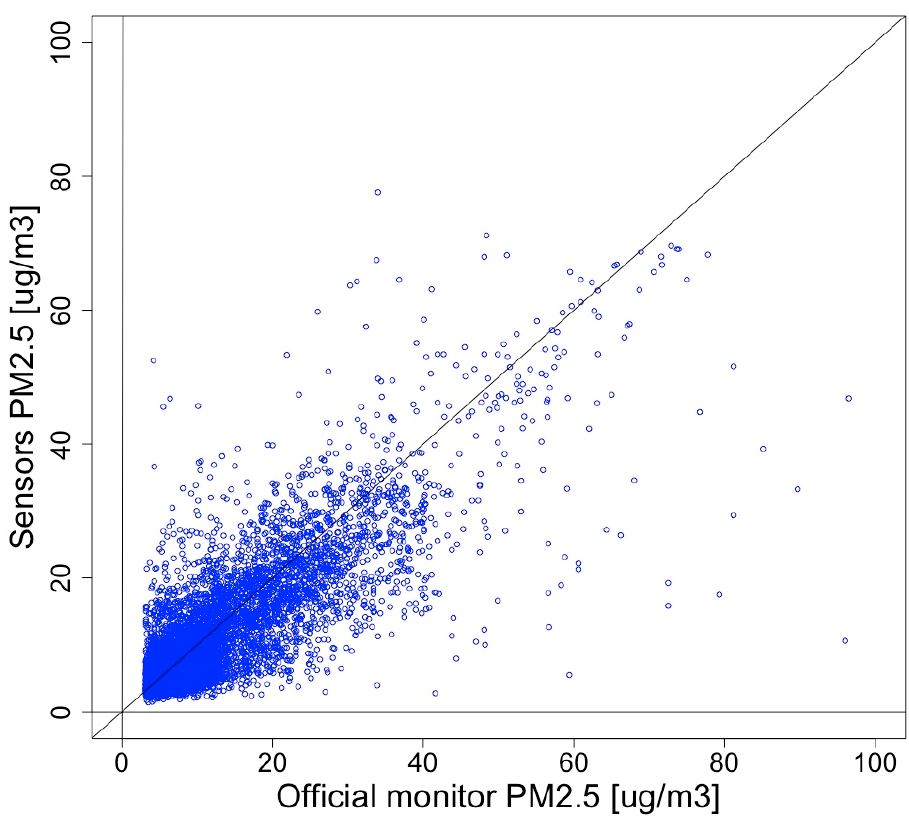
Figure 5. Correlation between the official hourly PM 2.5 measurements at AmsterdamVondelpark (x-axis) and the average of 20 (Nova SDS011) sensors in the center of Amsterdam (y-axis). All concentrations are in µg/m 3 .